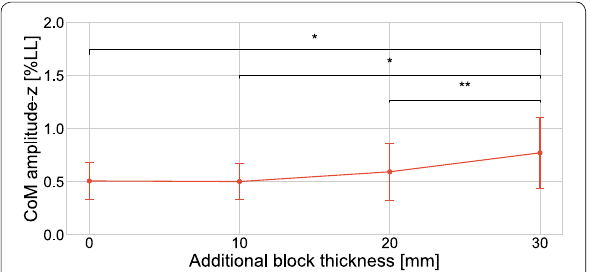
Fig. 13 Amplitude of the CoM motion on z-axis and additional block thickness. 20 mm and 30 mm thick blocks increased the amplitude. The single star (*) and twin stars (**) represent significant difference of the paired t-test ( P < 0.05 and P < 0.01 , respectively). These error bars represent standard deviation of means dominated by inter-participant